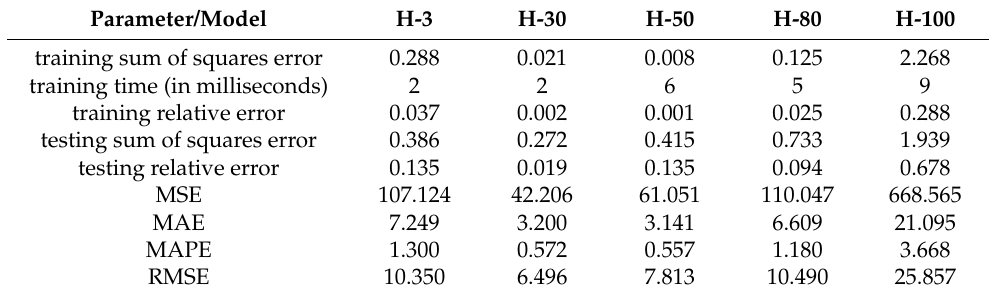
Table 5. Hyperbolic-tangent-function-based PCA–ELM model for a various numbers of hidden neurons.